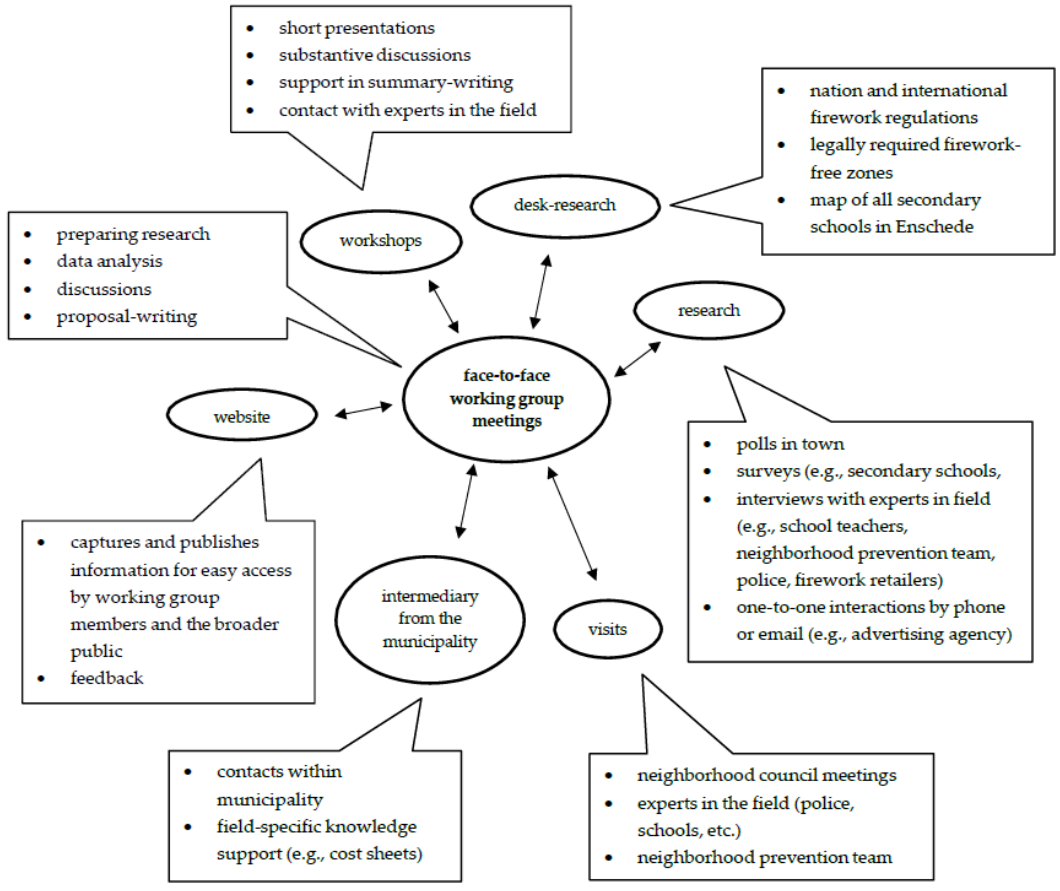
Figure 5. Mutual engagement and interaction within working groups.